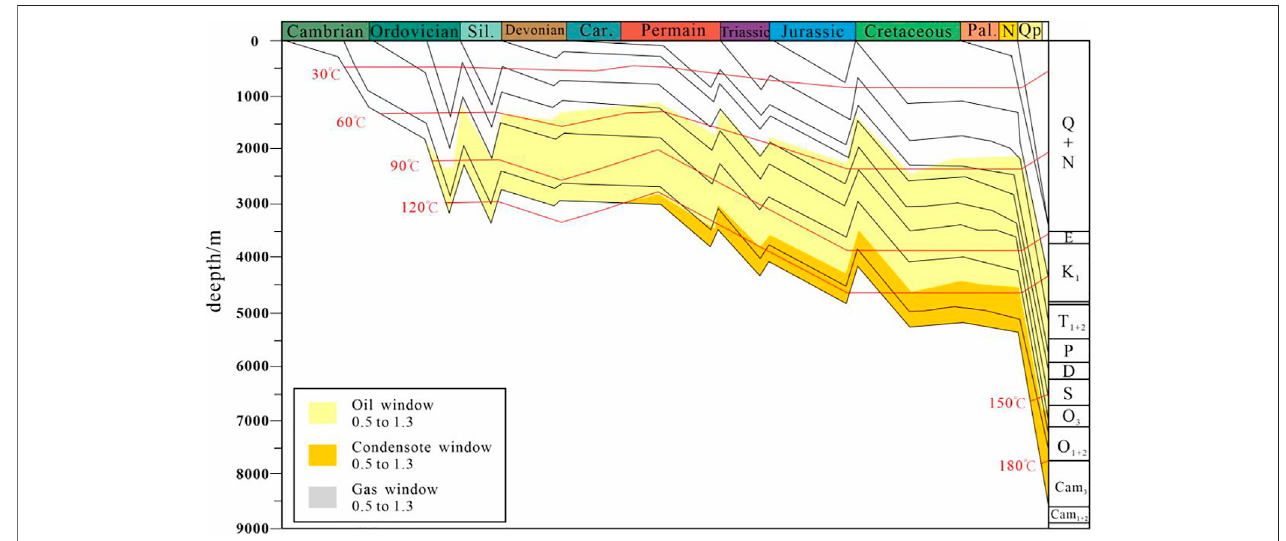
FIGURE 16 | Burial thermal evolution history of well Repu